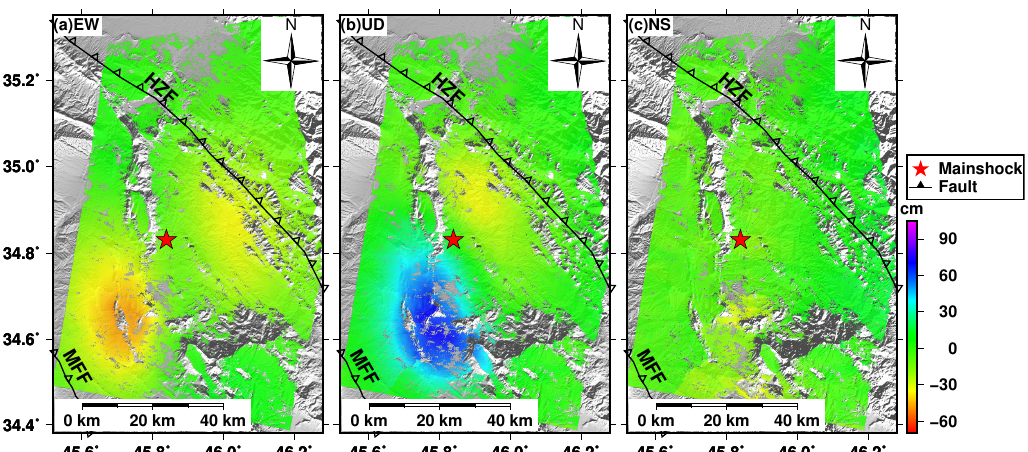
Figure 4. Interferograms of three-dimensional (3D) co-seismic deformation. ( a ) east-west (EW) direction, positive and negative values represent eastward and westward movements, respectively. ( b ) Up-Down (UD) direction, positive and negative values represent uplift and subsidence movements, respectively. ( c ) North-south (NS) direction, positive and negative values represent northward and southward movements, respectively. Black lines are faults; red stars represent the